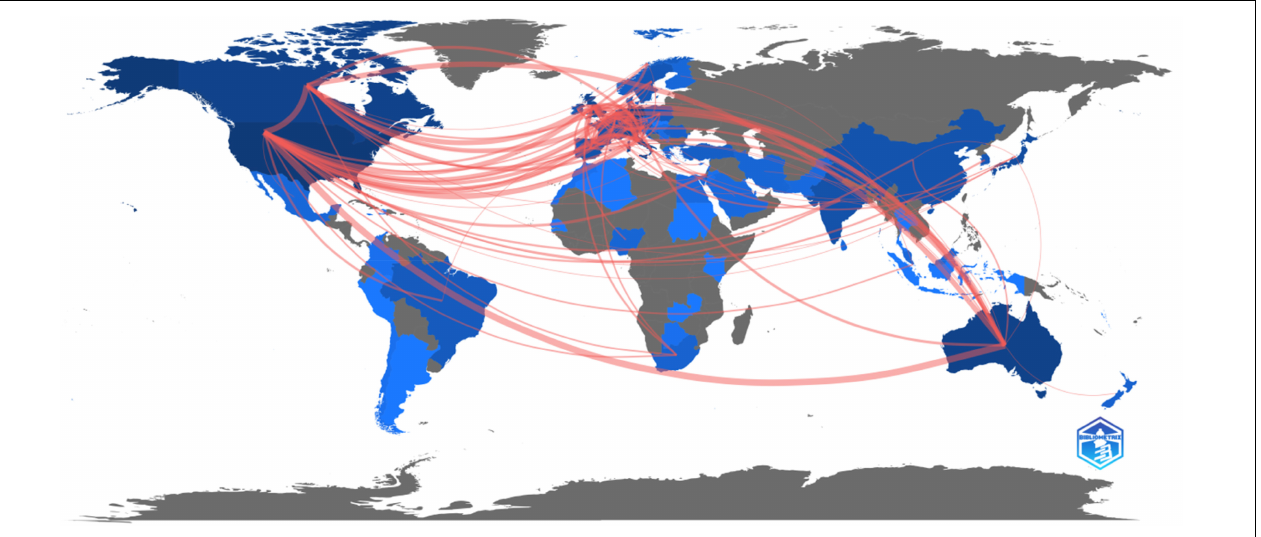
FIGURE 6 | Collaboration world map of countries or regions involved in psycho-oncology research between 1980 and 2021.